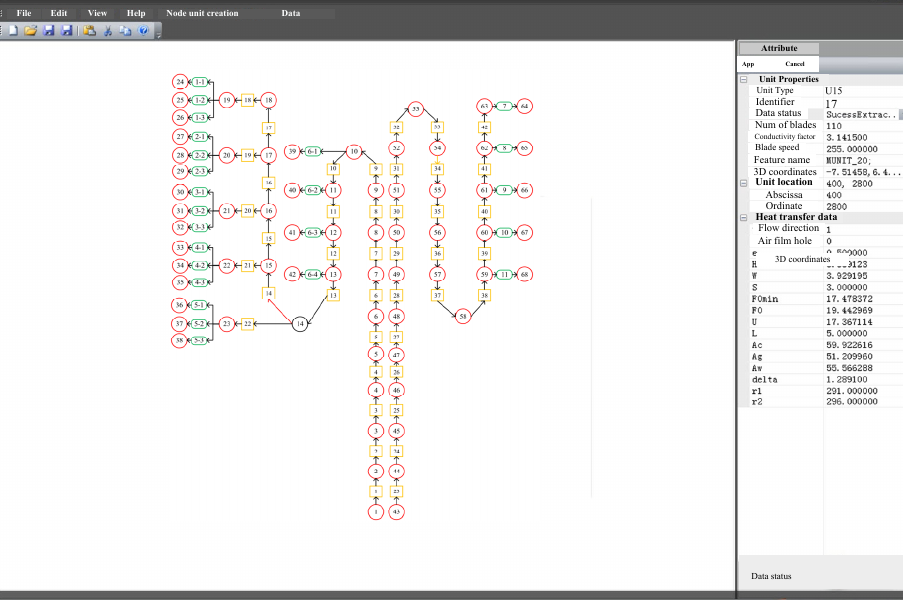
Figure 35. Pipe network drawing